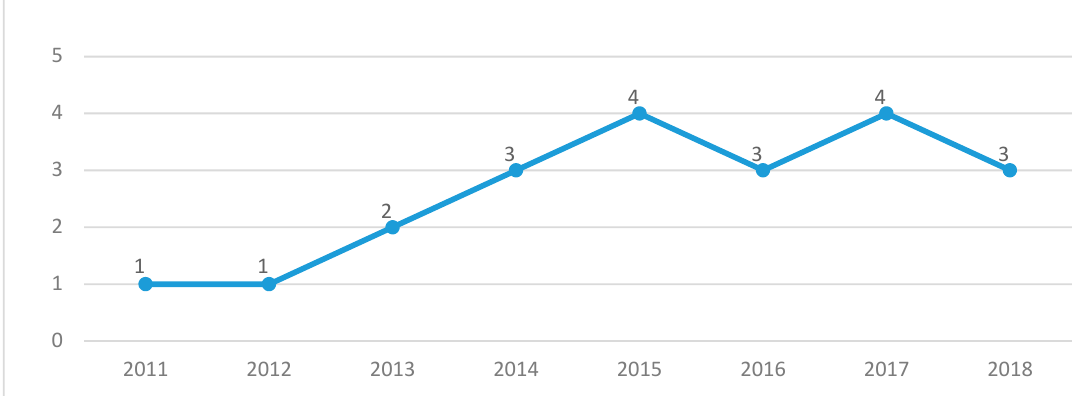
Figure 3. The number of studies published by year.